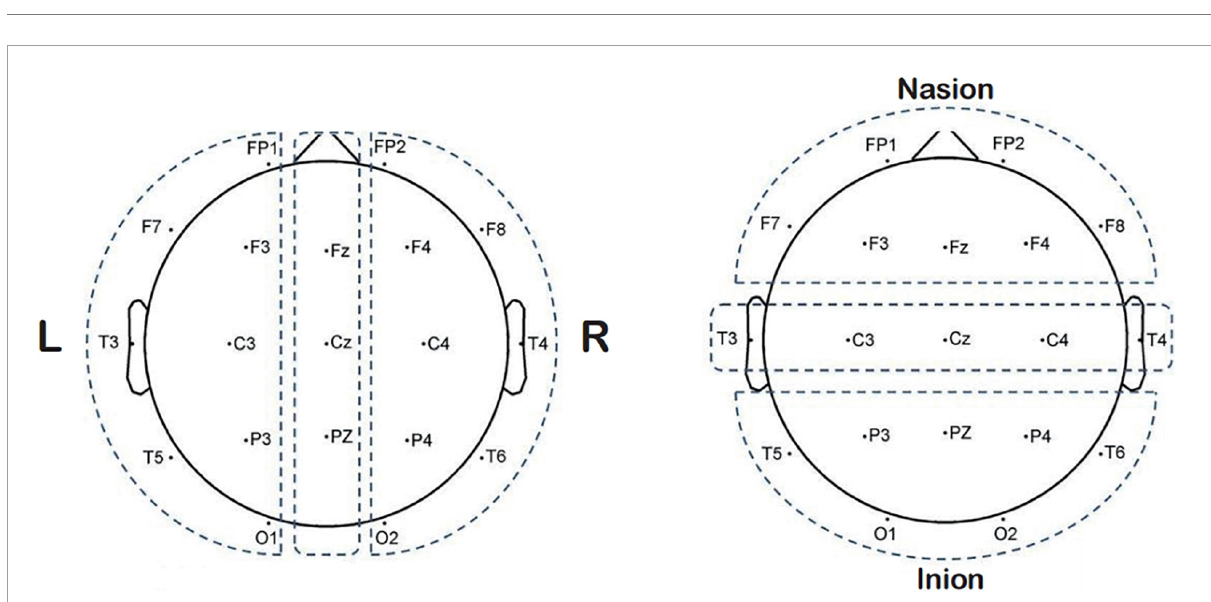
FIGURE2 Electrode position